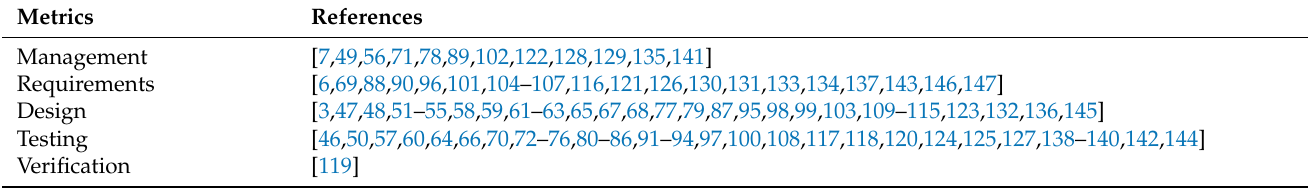
Figure 13. Studies by applied areas in SE. Table 6. List of references of the applied